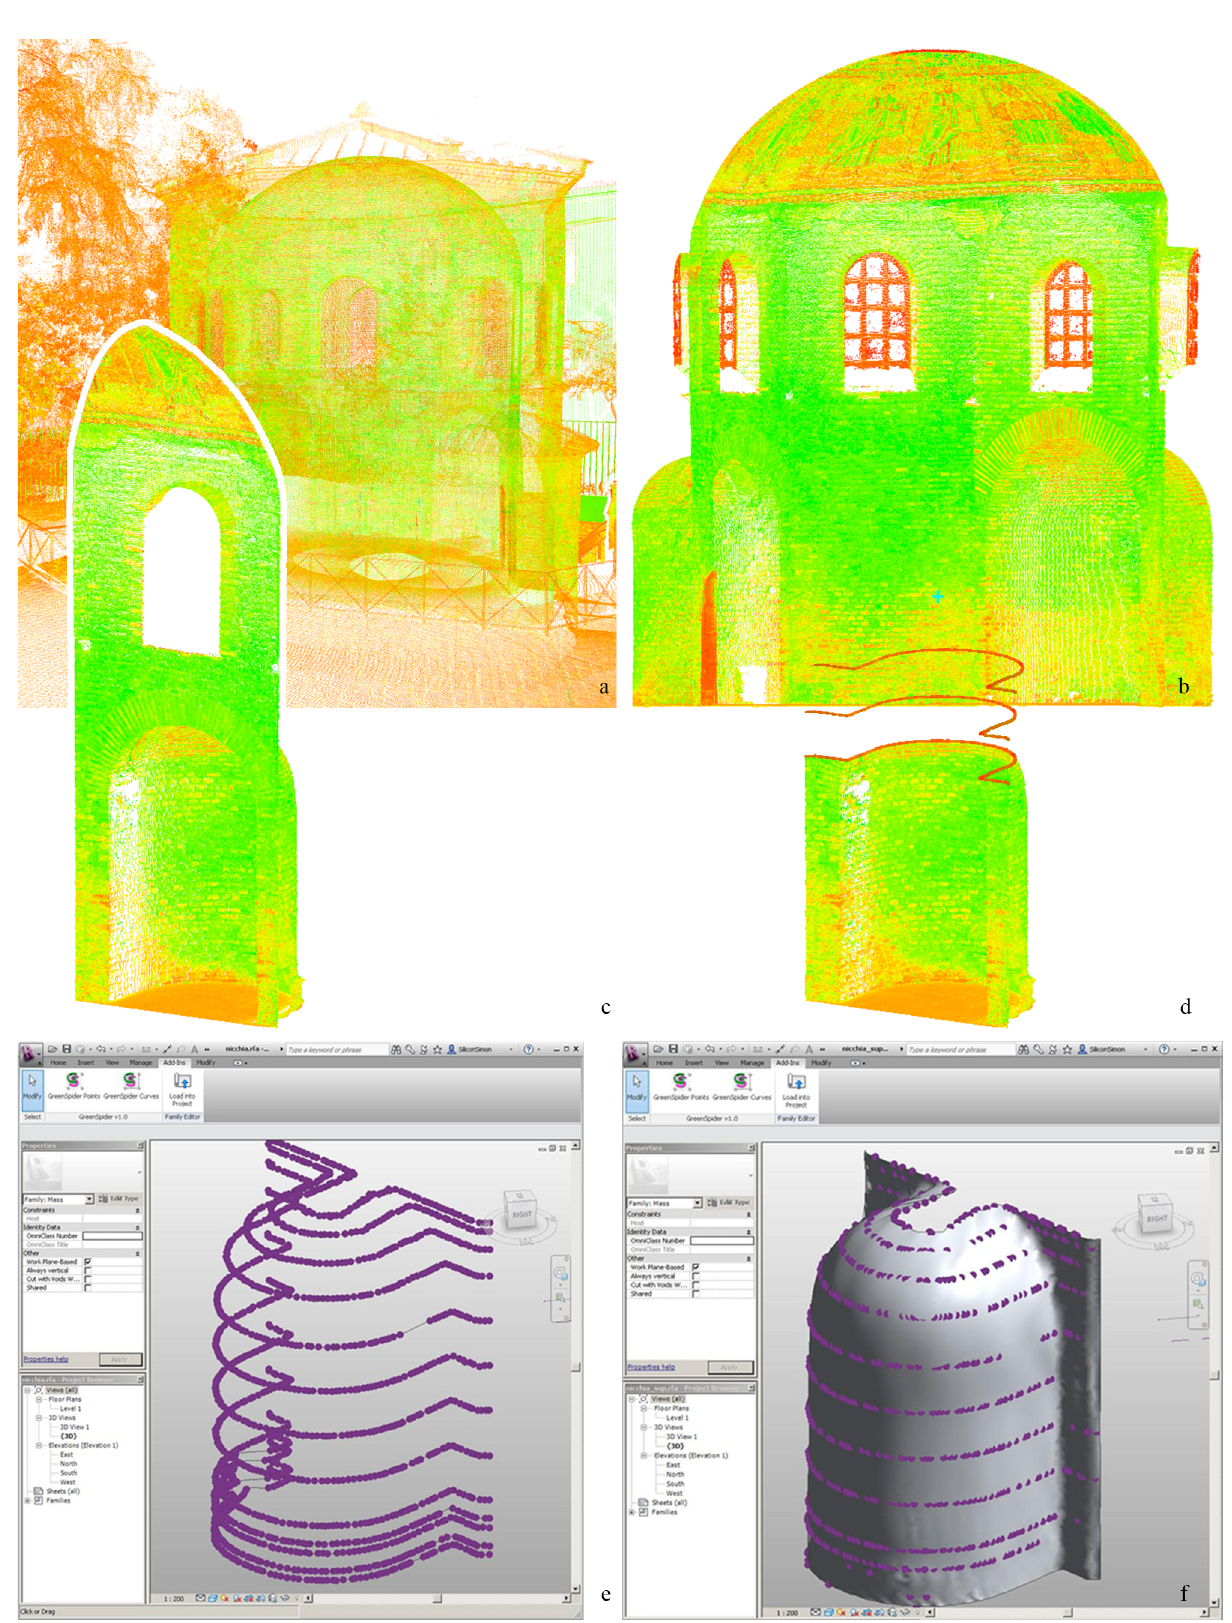
Figure 3. The adopted pipeline. A complex point cloud (a) is firstly segmented in its main entities (b) and single elements (c). These last geometries are then sectioned (d) in order to drastically reduce geometric complexity and meanwhile preserve singularities that are indispensable for the following 3d reconstruction in the BIM environment. Through the use of the developed GreenSpider application, these data are then imported into the Revit Architecture (e). The snappable sets of points are then connected through curves (e) and afterwards inter-connected using parametric entities